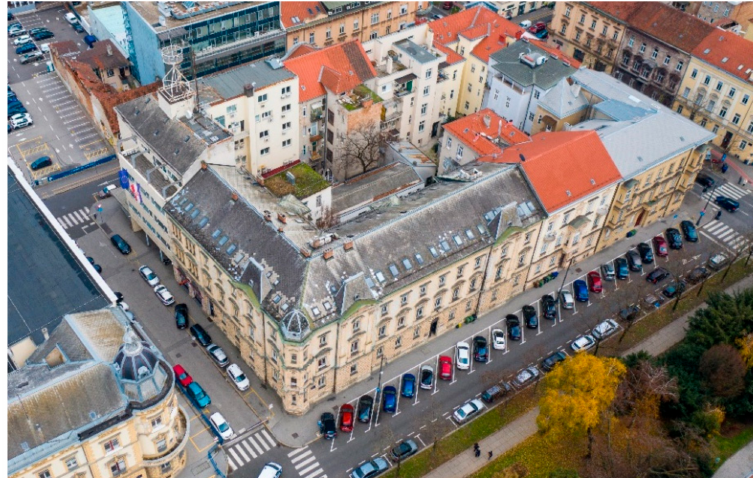
Figure 4. Aerial view of the building (photo credit: Mislav Stepinac).